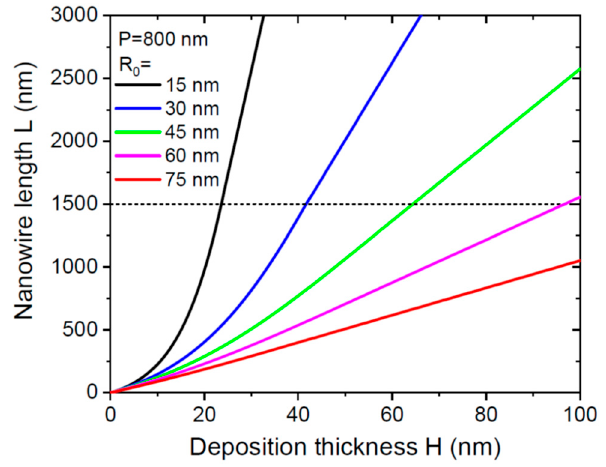
Figure 2. NW length versus deposition thickness at a fixed pitch of 800 nm for different NW radii shown in the legend. The dashed line corresponds to a diffusion length λ des of 1500 nm.